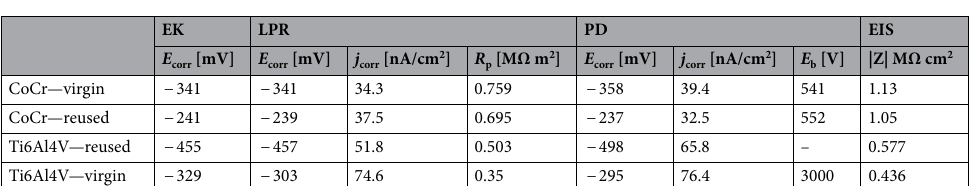
Table 7. Electrochemical parameters obtained from the different types of electrochemical measurement (EK—corrosion potential, LPR—linear polarization resistance, PD—potentiodynamic polarization and EIS— electrochemical impedance